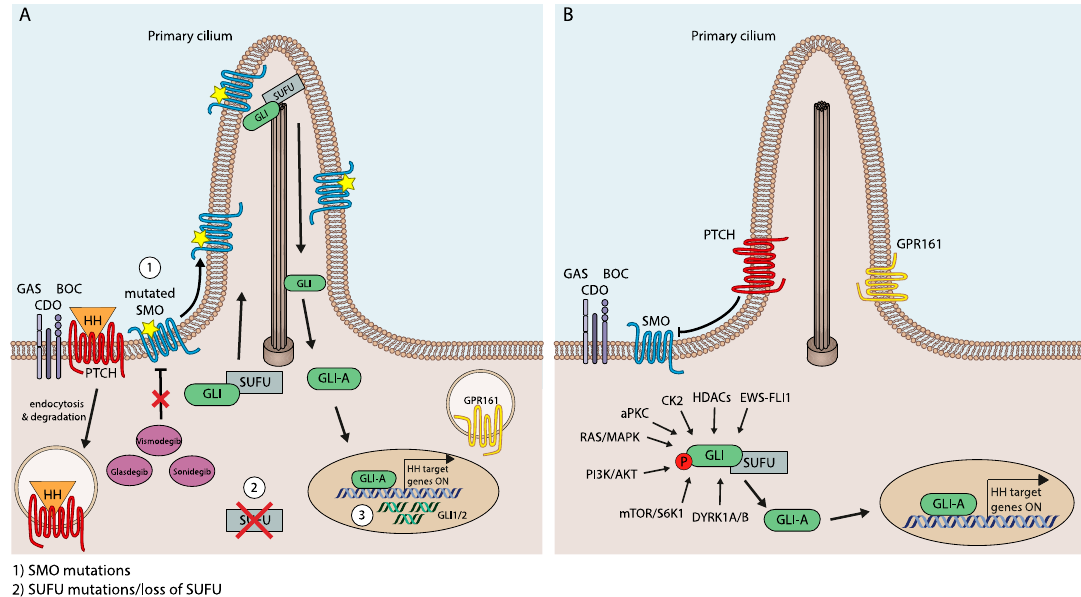
Figure 2. Genetic and molecular mechanisms conferring resistance to SMO inhibitors. ( A ) Three distinct mechanisms accounting for SMO inhibitor (SMOi) resistance are displayed: (1) Mutations in SMO itself, (2) genetic loss of downstream pathway repressors such as Suppressor of Fused (SUFU), and (3) genomic amplification of pathway effectors such as GLI2. ( B ) SMO-independent mechanisms of oncogenic GLI regulation contributing to the development of resistance to SMO inhibitors (for details, see main text).